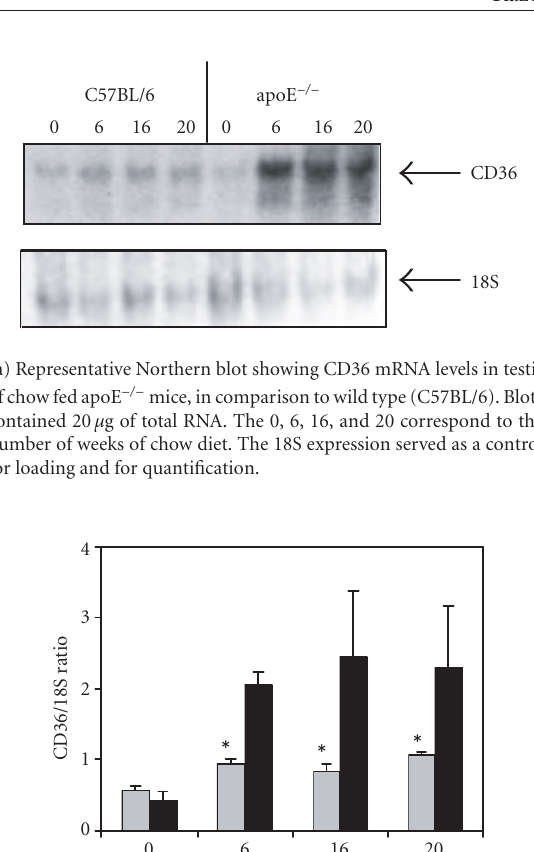
(deletion, insertion, and punctual mutation) in the CD36 gene have been identified in type I deficiency [34]. Myocar- dial capillary endothelial cells, in type I CD36-deficient in- dividuals, show a lack of myocardial LCFA accumulation and metabolism in the myocardium [33, 34, 35, 36].